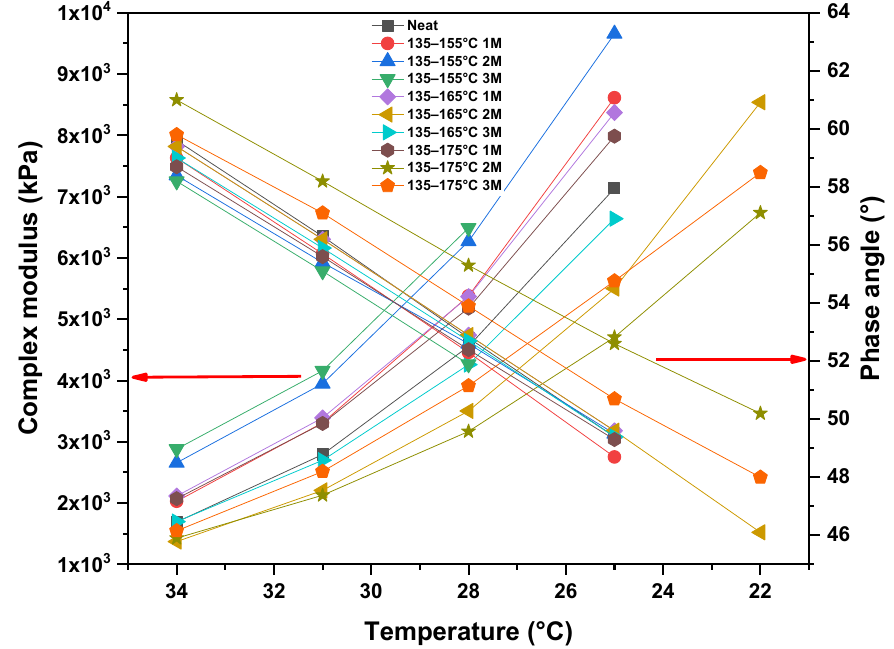
Figure 22. Complex modulus and phase angle under different temperatures at the PAV-aged stage. From Figures 23 and 24, we observe that at the unaged and the short-term-aged stages, as the testing temperature increased, the rutting factor (|G*|/sin( δ )) declined, which indi- cates that the property of the bitumen’s rutting resistance at a high temperature decreased.